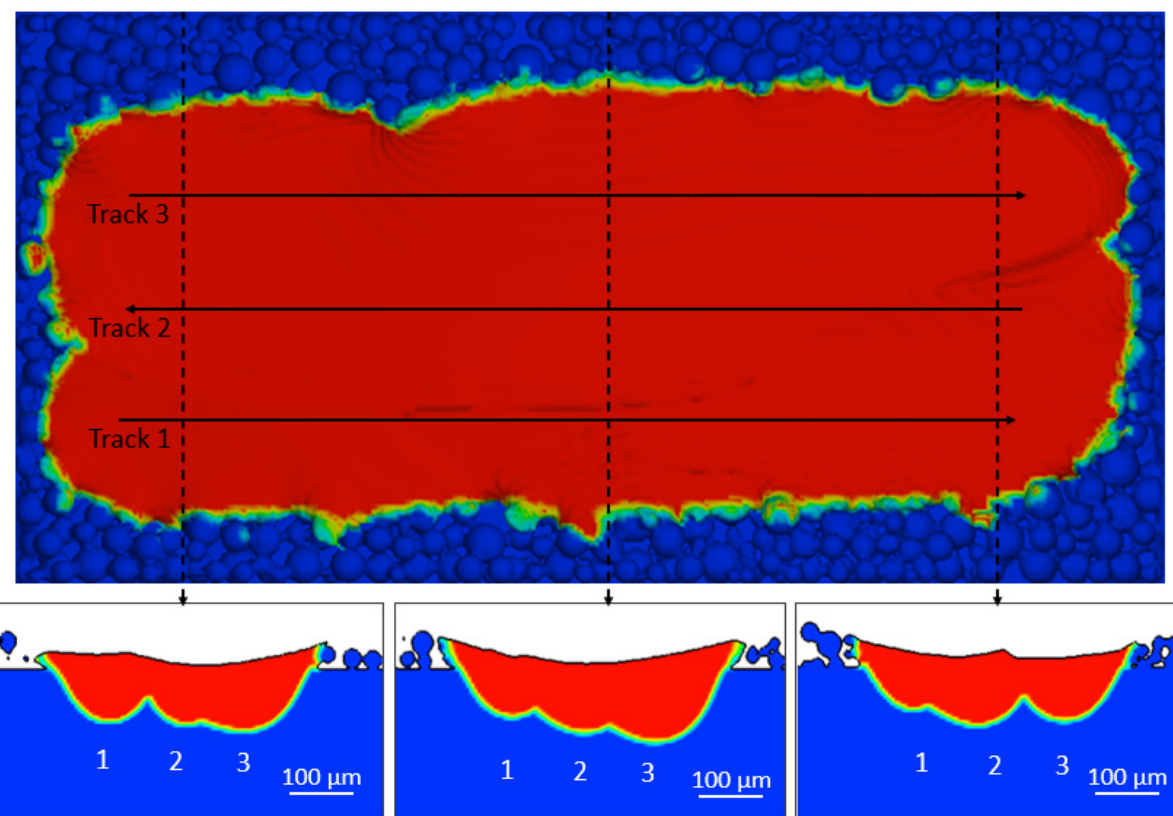
Figure 14. Melt profile formed at different regions along the scan